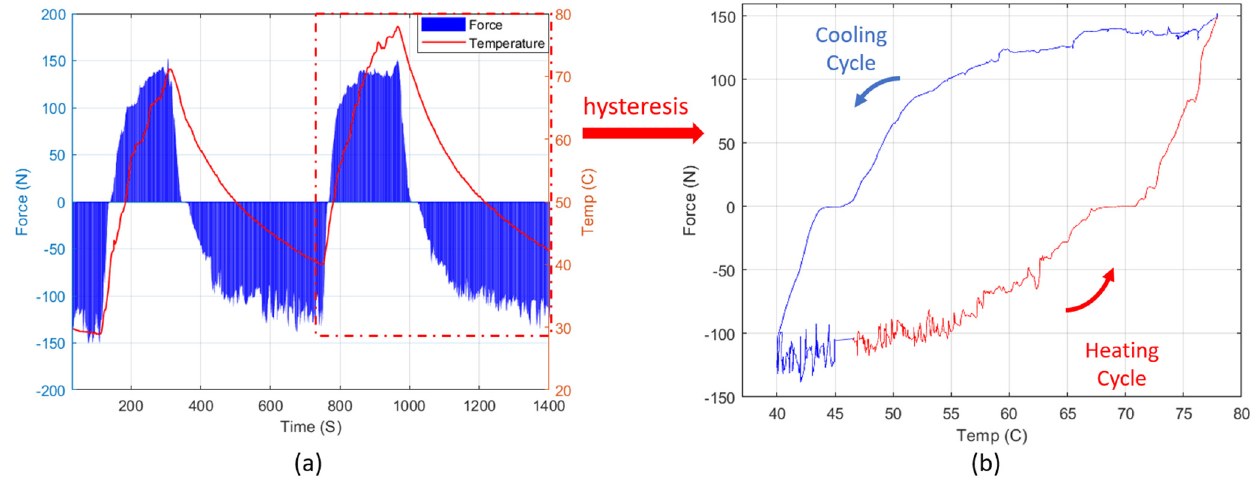
Figure 22. ( a ) Force and temperature vs. time; ( b ) force vs. temperature (force hysteresis behavior).